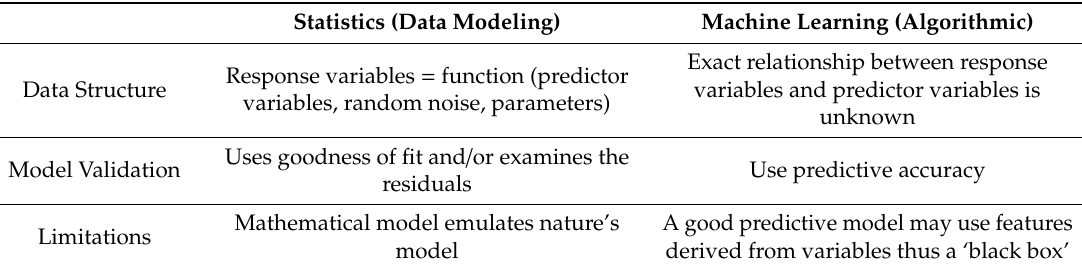
Table 2. Contrasting statistics and machine learning techniques.